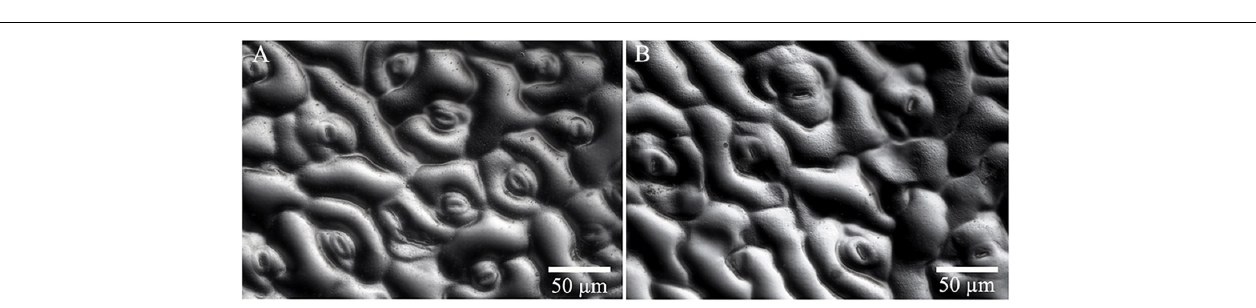
FIGURE 8 | Characterization of somatic embryos and in vitro plantlets derived from diploid and tetraploid embryogenic cells of Magnolia officinalis . Diploid (A) and tetraploid (B) somatic embryos 5 weeks after somatic embryo initiation. Diploid (C) and tetraploid (D) plantlets conversion from somatic embryos. (E) The length (open bars) and diameter (closed bars) of diploid and tetraploid somatic embryos of M. officinalis 6 weeks after somatic embryo initiation ( n = 30). (F) The biomass of diploid and tetraploid plantlets of M. officinalis 3 months after somatic embryo germination ( n = 12).